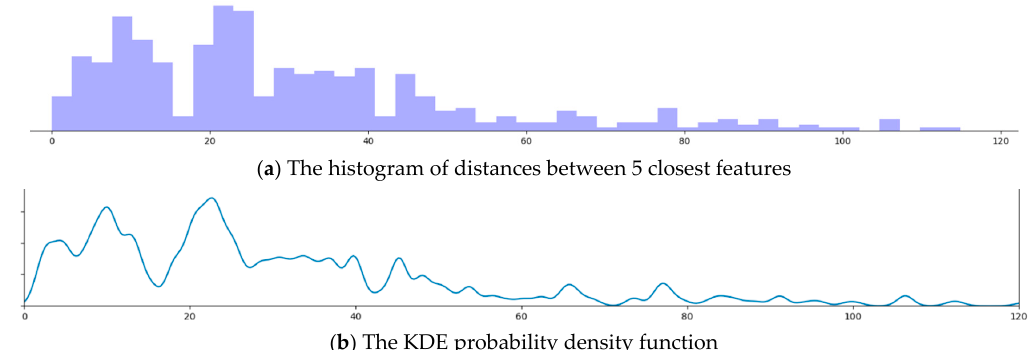
Figure 13. The histogram and Kernel Density Estimator (KDE) probability density function for distance. The horizontal axis represents the Hamming distance starting from 0. In ( a ), the vertical axis represents the number of features at a particular distance. In ( b ), the vertical axis represents the probability density of a particular distance. Table 1. Feature Descriptor Accuracy.